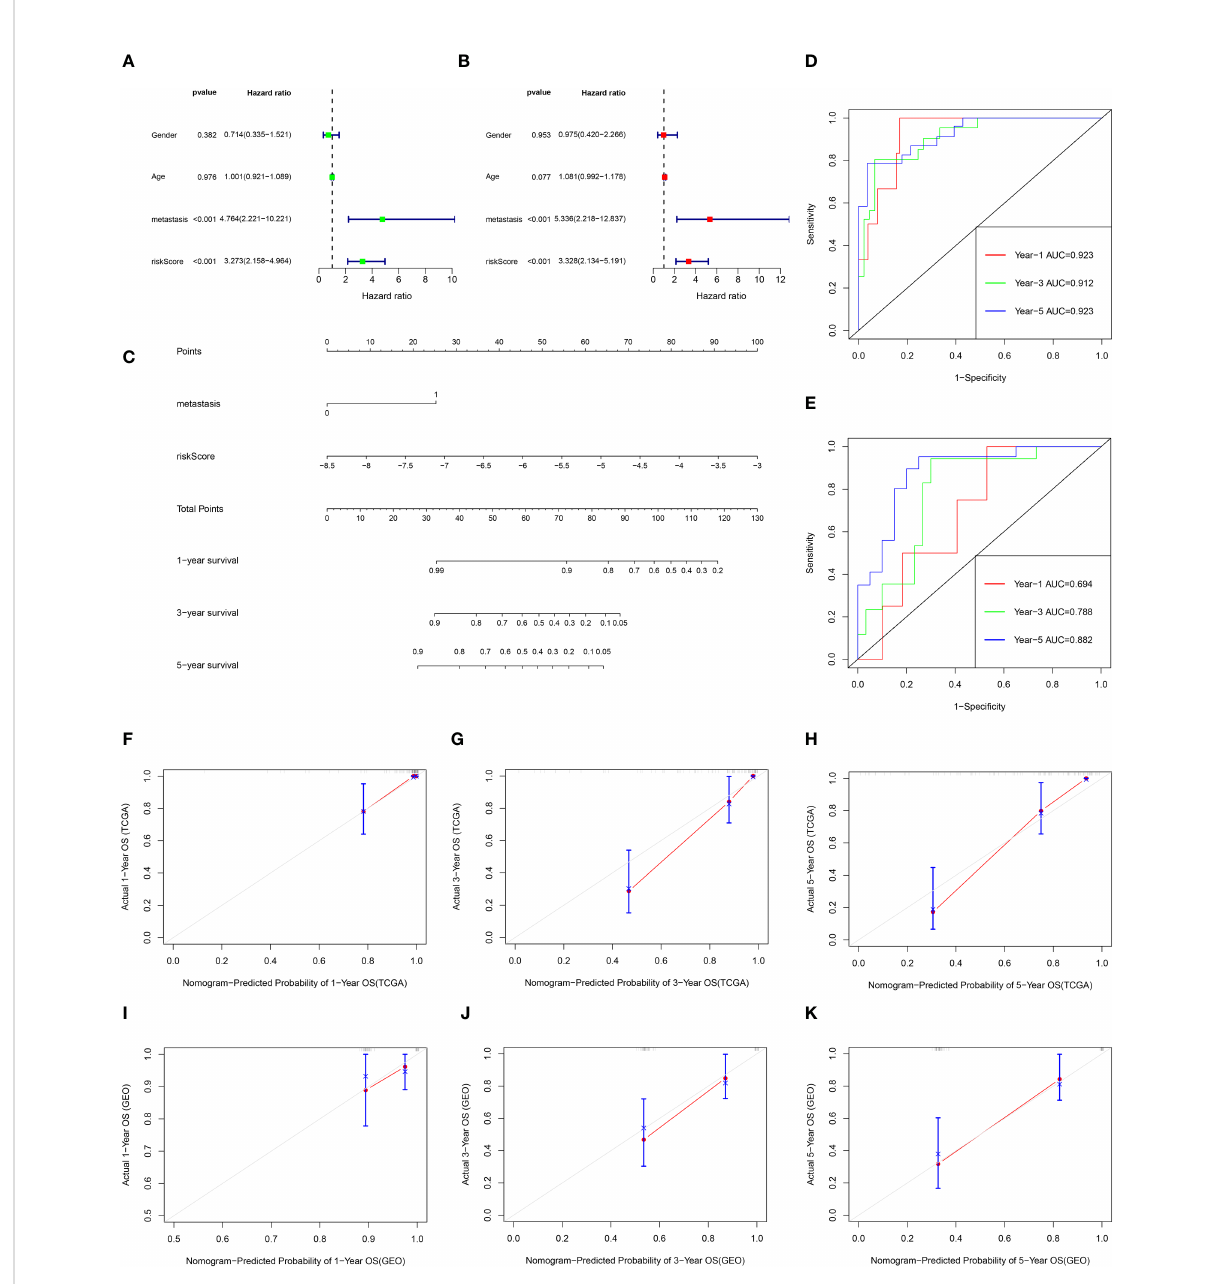
FIGURE 8 The prognostic value of clinical features and risk scores, and construct the nomogram. (A, B) Results of the univariate and multivariate Cox regression analyses regarding OS in the TCGA cohort. (C) Nomogram plots of TCGA cohort. (D) The ROC curve analysis of the TCGA cohort showed that AUCs of 1-year, 3 ‐ year, and 5 ‐ year OS was 0.923, 0.912, and 0.923, respectively. (E) The ROC curve analysis of the GEO cohort showed that AUCs of 1-year,3 ‐ year, and 5 ‐ year OS was 0.694, 0.788, and 0.882, respectively. (F – H) Calibration curves for 1, 3, and 5-year OS of TCGA data. (I – K) Calibration curves for 1, 3, and 5-year OS of GEO